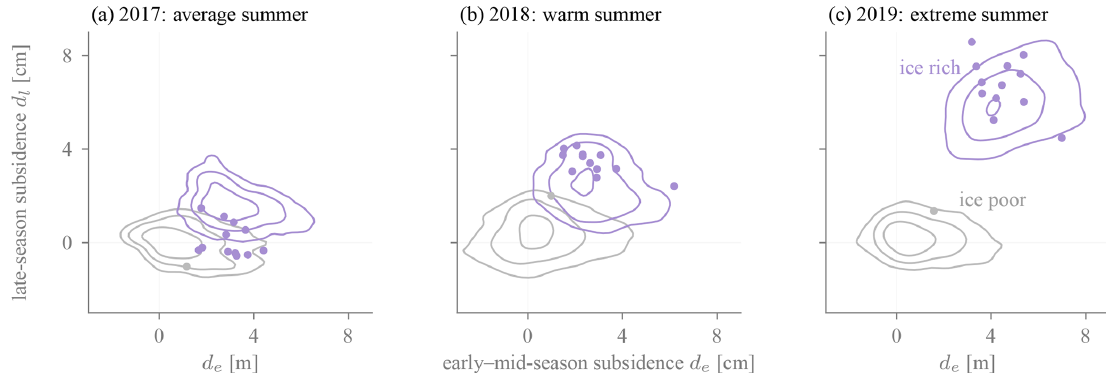
Figure 8. Contour plot of a kernel density estimate of the early–mid-season and late-season subsidence for ice rich (purple) and ice poor (grey), as determined independently by manual mapping (Fig. 7d). The markers correspond to the values observed at the location of the ice cores (triangles in Fig. 5). Negative values, corresponding to heave, are of comparable magnitude to the referencing accuracy of ∼ 1cm.